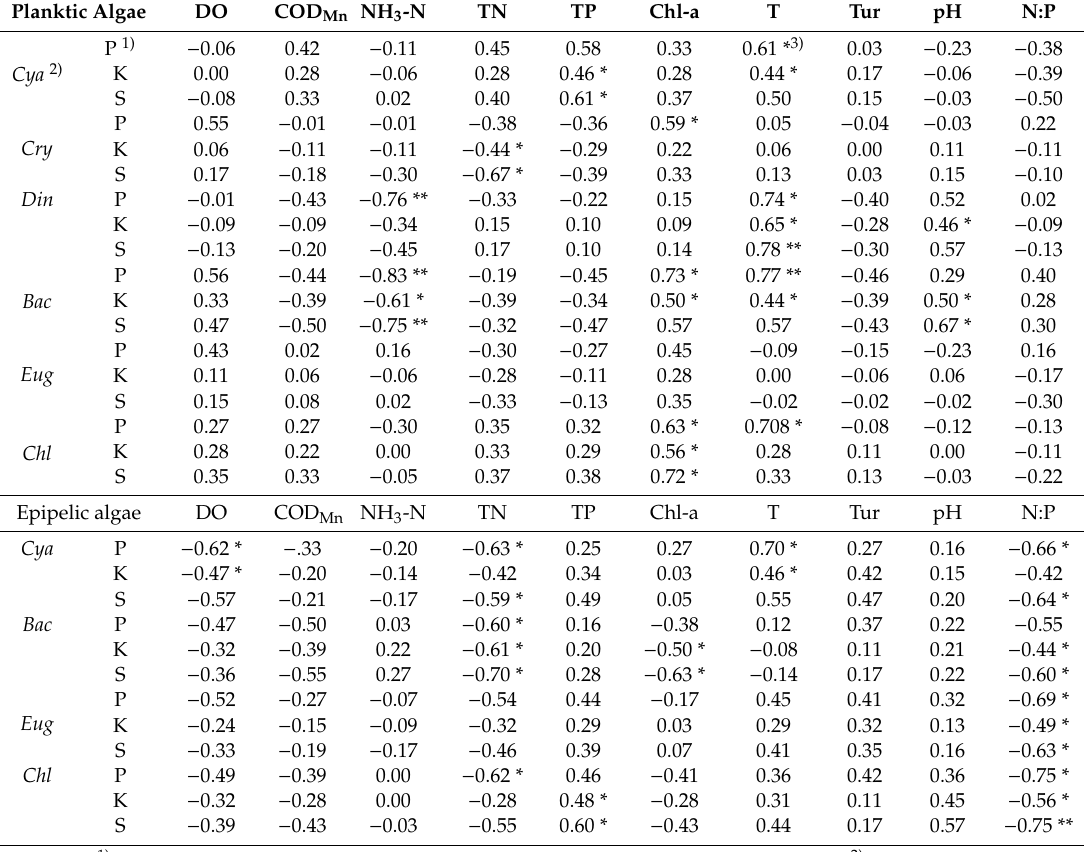
Table 3. Correlation analysis between algae and environmental factors ( n =